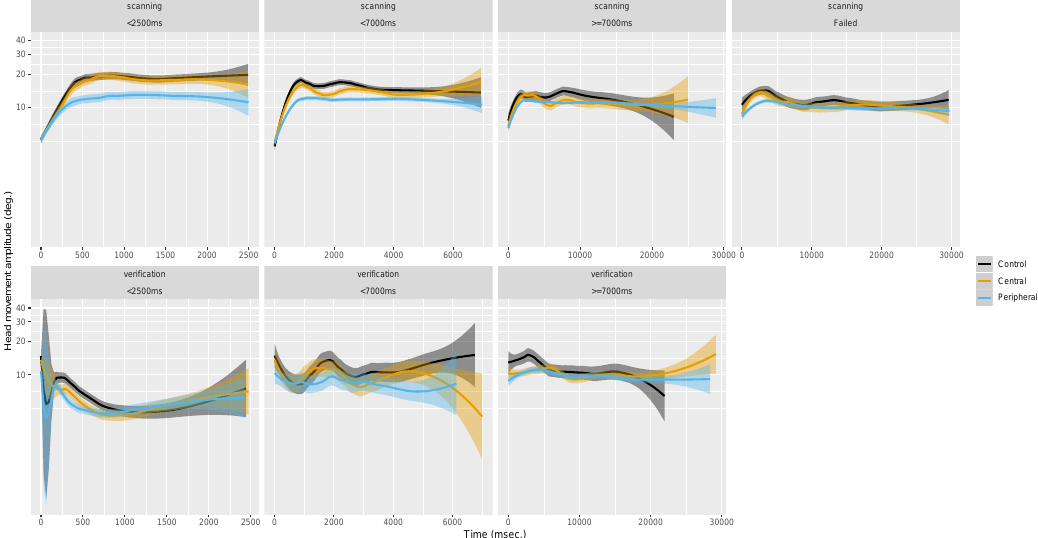
Figure A8. Time-course of average head movements amplitude during saccades as a function of search phase (trial duration subgroups do not overlap). Ribbons show 95%CI. Control condition appears in black, central in orange and peripheral in